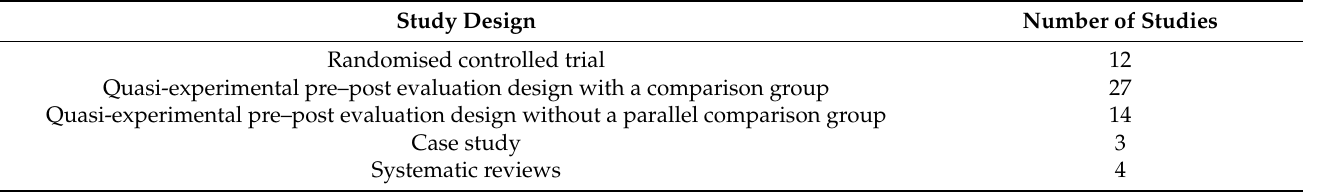
Table 2. Study design of selected